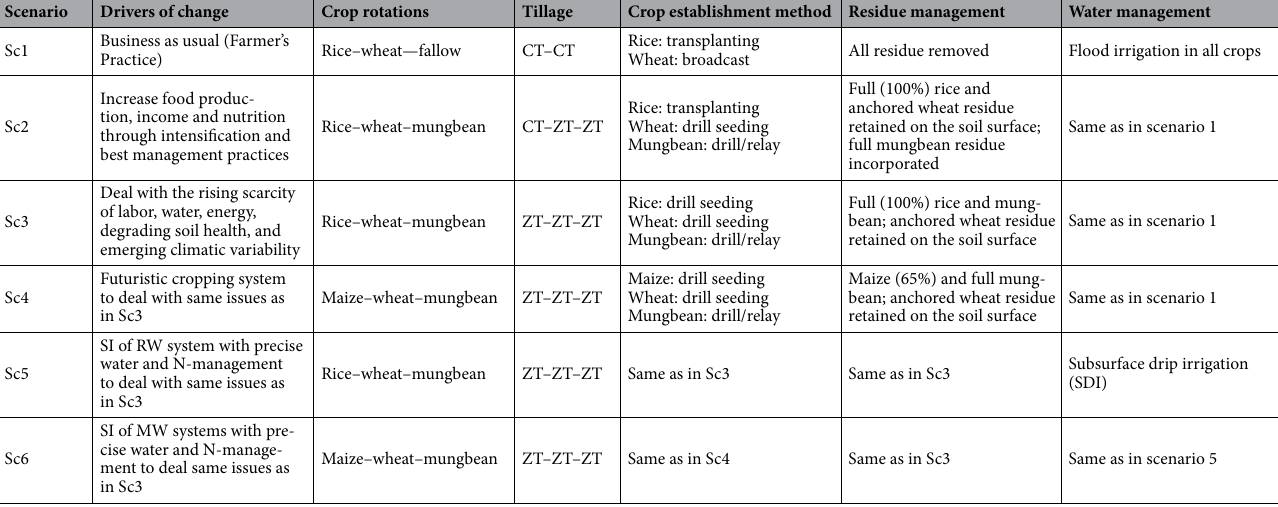
Table 1. Drivers of agricultural change, crop rotation, tillage, crop establishment method, and residue and water management under different scenarios. CT conventional tillage, ZT zero till, CA